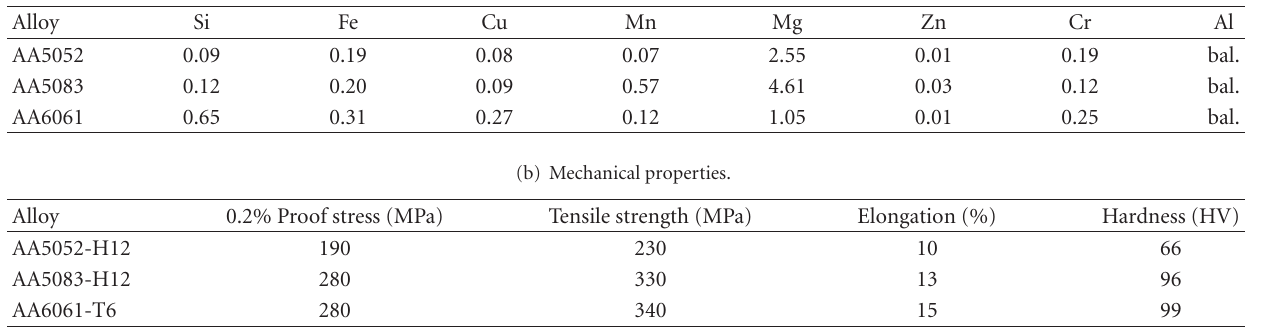
Table 1: Chemical composition and mechanical properties of the used aluminum alloys.